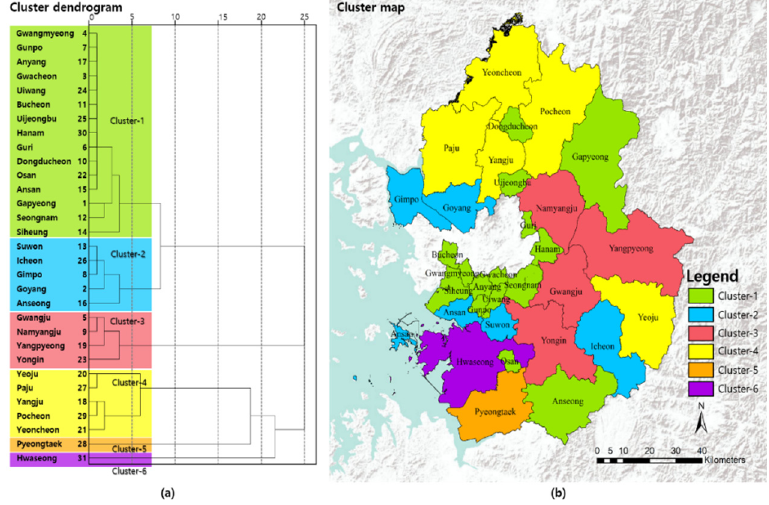
Figure 7. ( a ) Cluster dendrogram and ( b ) cluster map of research cities.